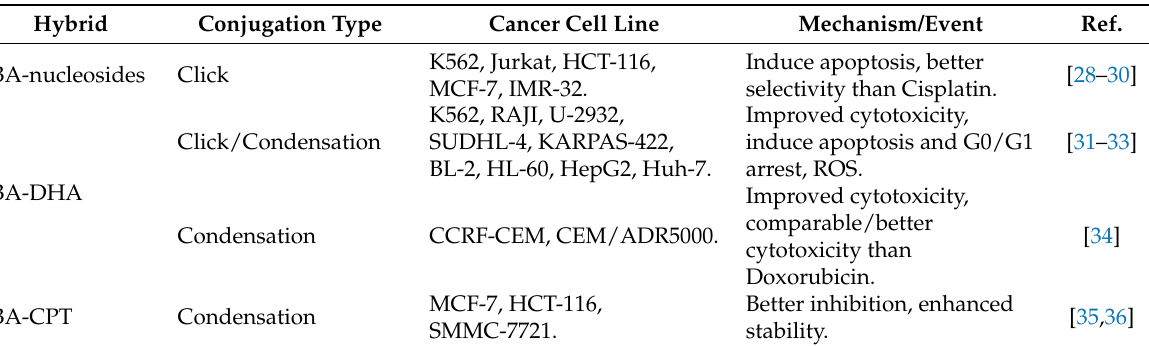
Table 1. Summary of BA hybrids.